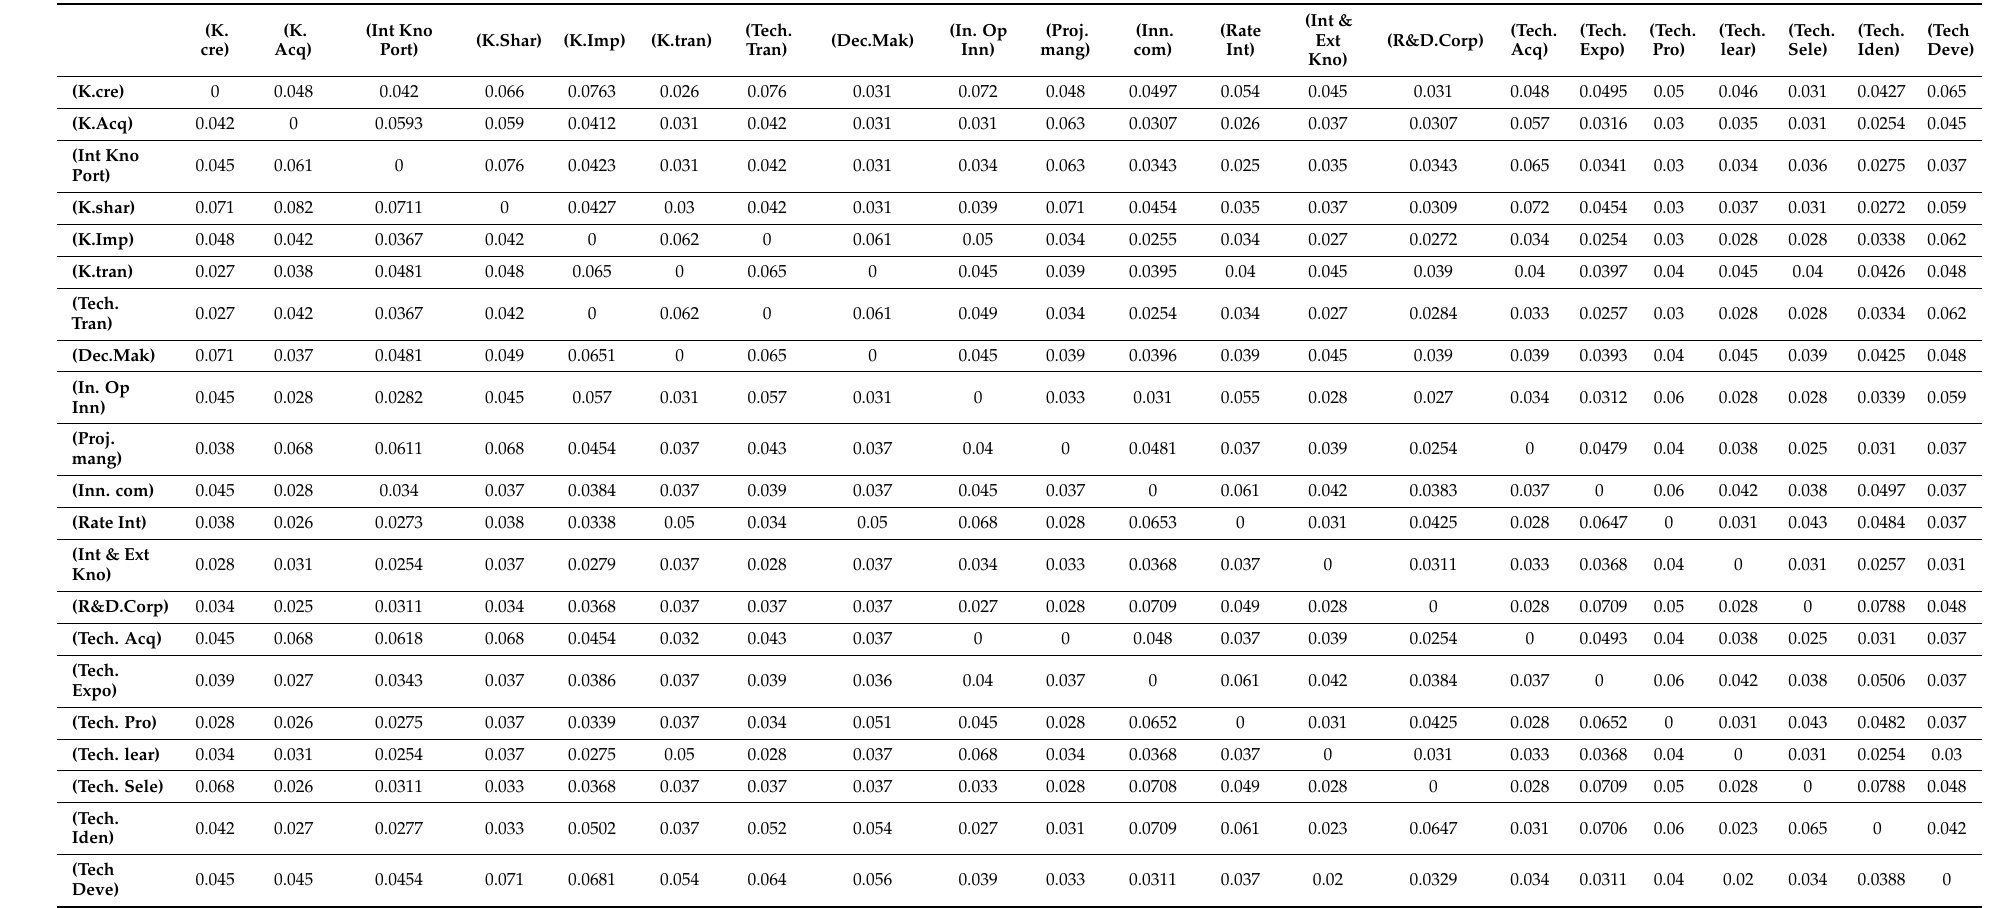
Table 5. Normalized initial direct-relation T (Criteria)